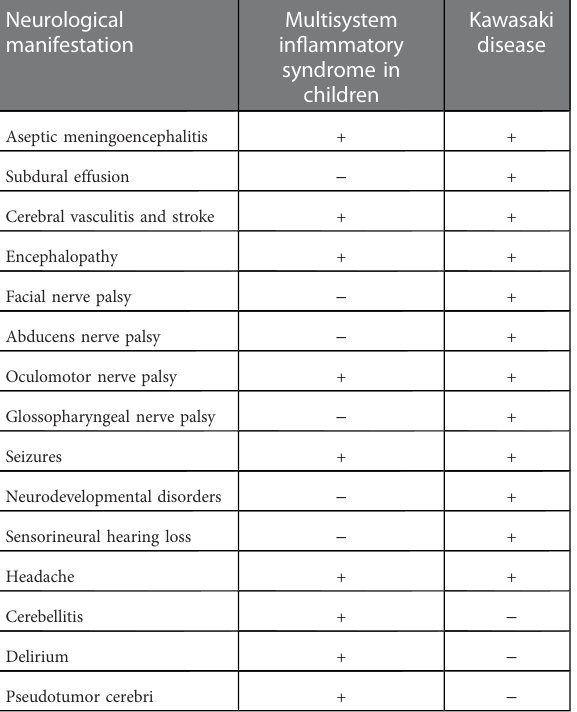
TABLE 3 Differences between neurological manifestations of Kawasaki disease and multisystem in fl ammatory syndrome in children. Neurological manifestation